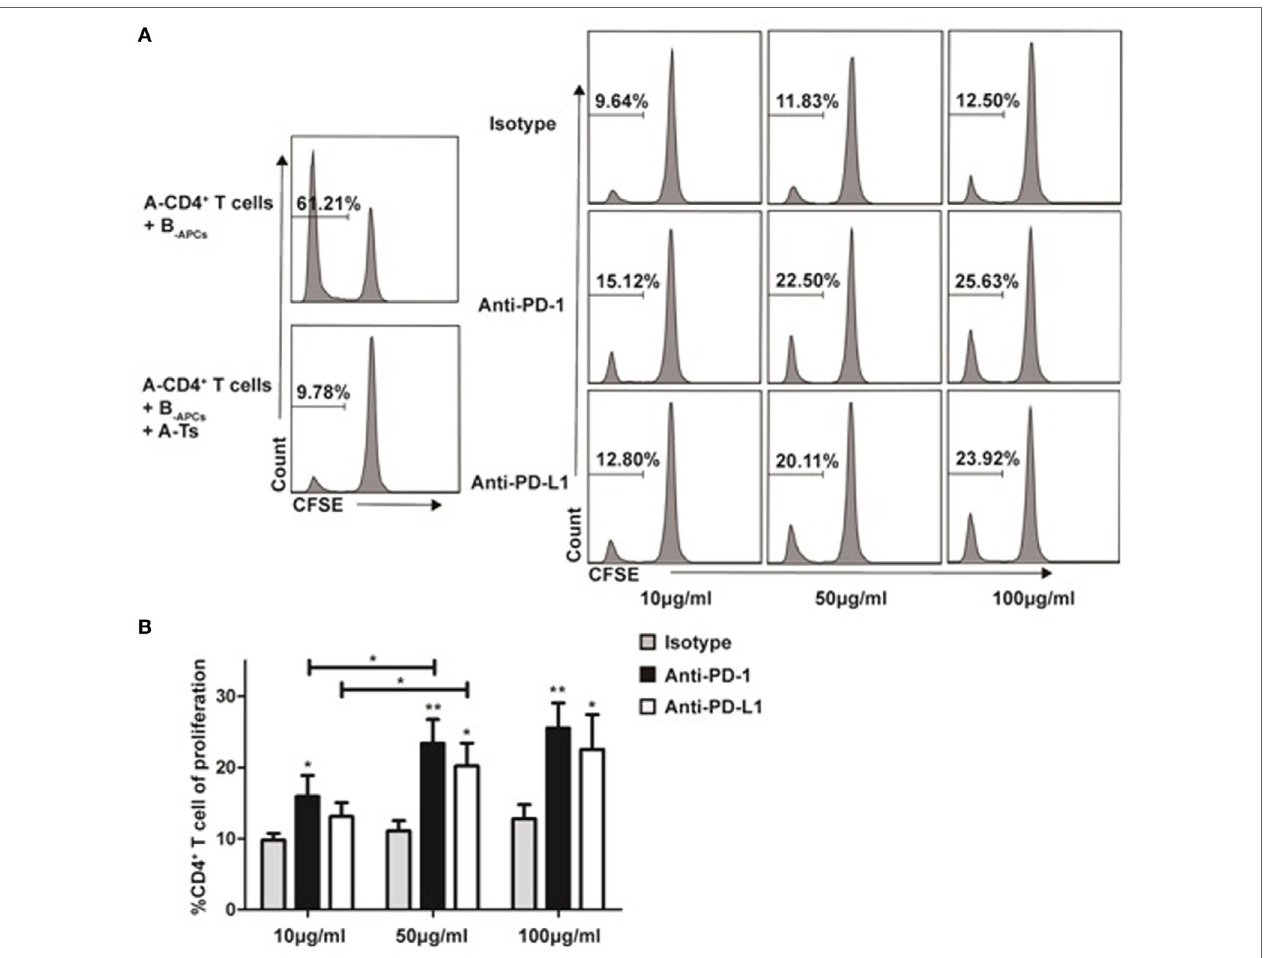
FigUre 8 | Programmed death-ligand 1 (PD-1):programmed death-ligand 1 (PD-L1) signaling plays a critical role in the suppressive function of in vitro expanded CD8 + CD28 − Ts cells Suppression assays were set up as described in Figure 3a at an S:R ratio of 0.5:1. The proliferation of the CD4 + T cells was measured by carboxyfluorescein diacetate succinimidyl ester dilution. (a) The percentages of proliferating CD4 + T cells in the presence of anti-human PD-1, anti-human PD-L1 or isotype control antibody at concentrations of 10, 50, or 100 µg/ml were shown. (b) The average percentages of proliferating CD4 + T cells in different antibody concentration groups. The bar graphs indicate the means ± SD, n = 3. * and ** indicate significant difference within group and between different groups. * p < 0.05 and ** p <